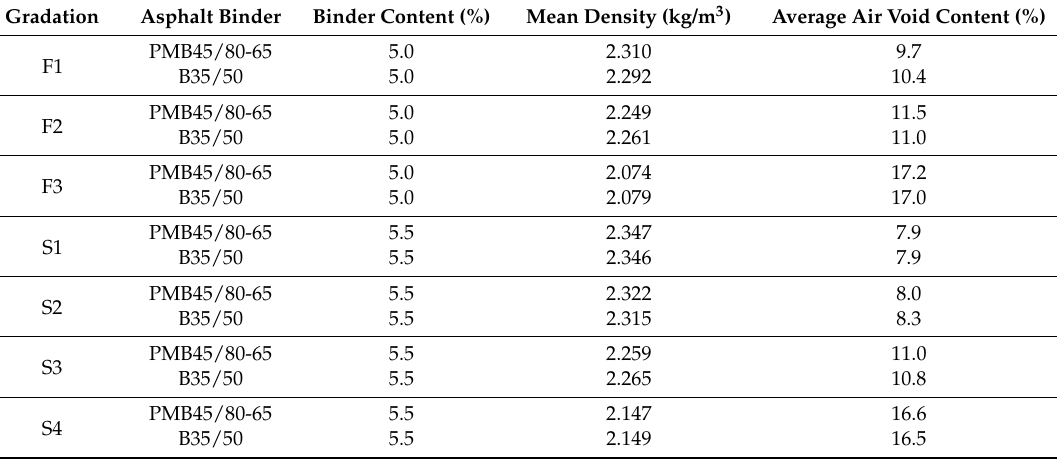
Table 4. Properties of asphalt concrete Table 3. Properties of the evaluated asphalt binders.